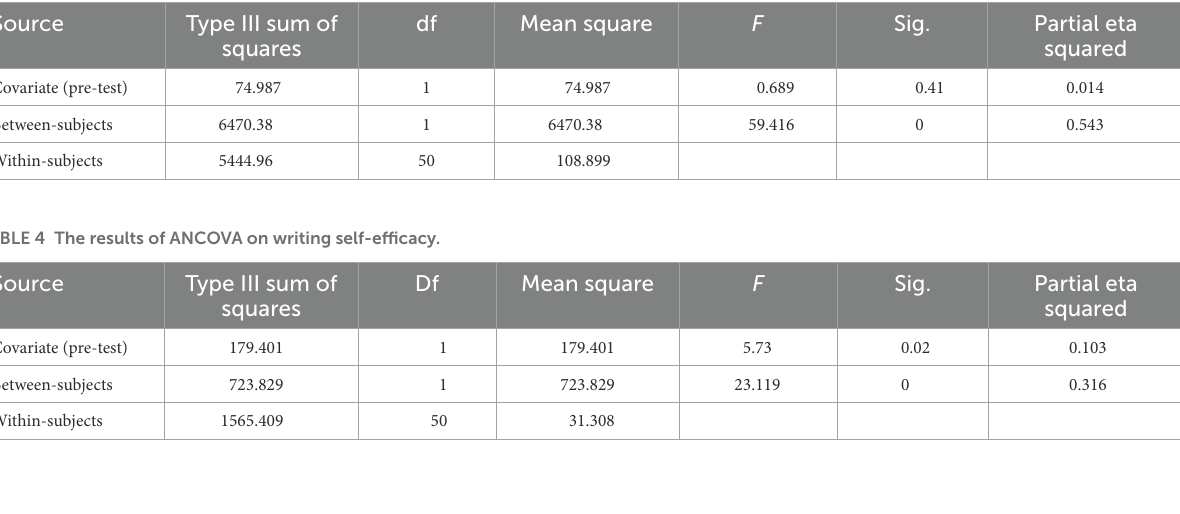
TABLE 3 The results of ANCOVA on writing skill.